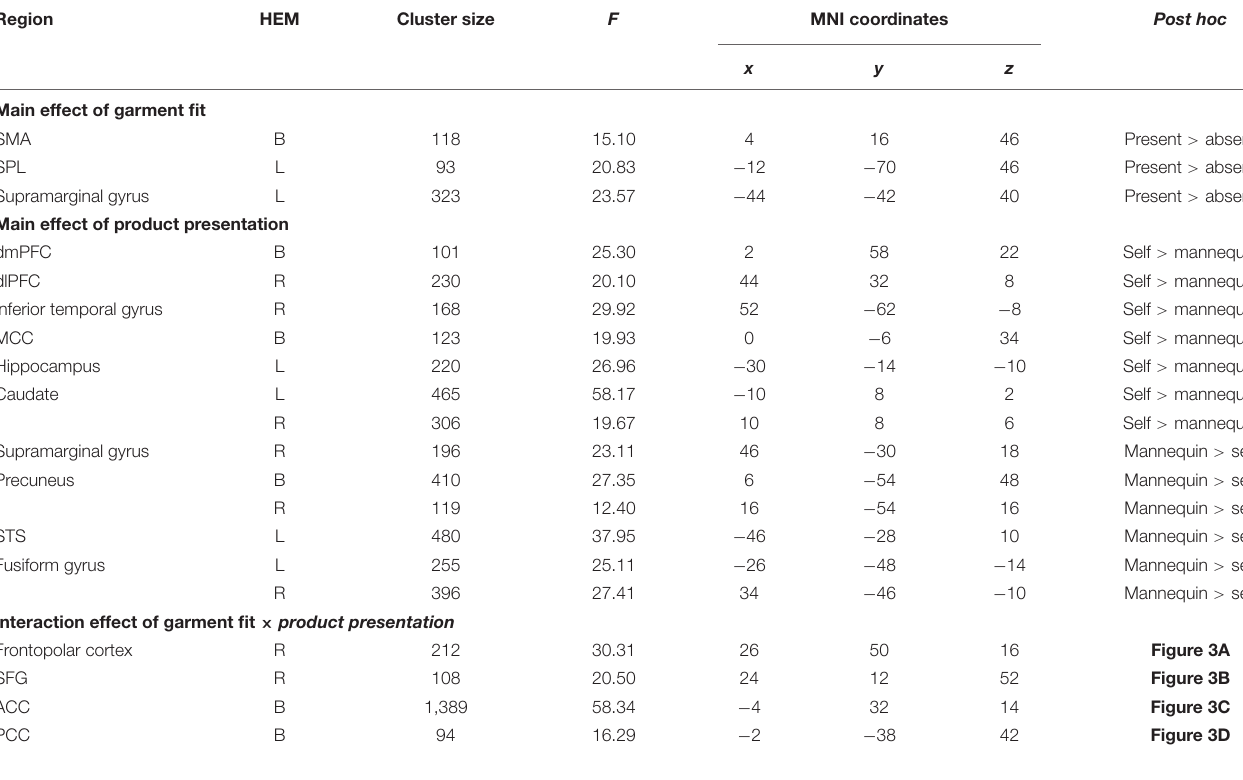
TABLE 2 | Significant brain regions in the mass univariate analysis showing the effects of garment fit and product presentation type during the purchase deliberation phase.